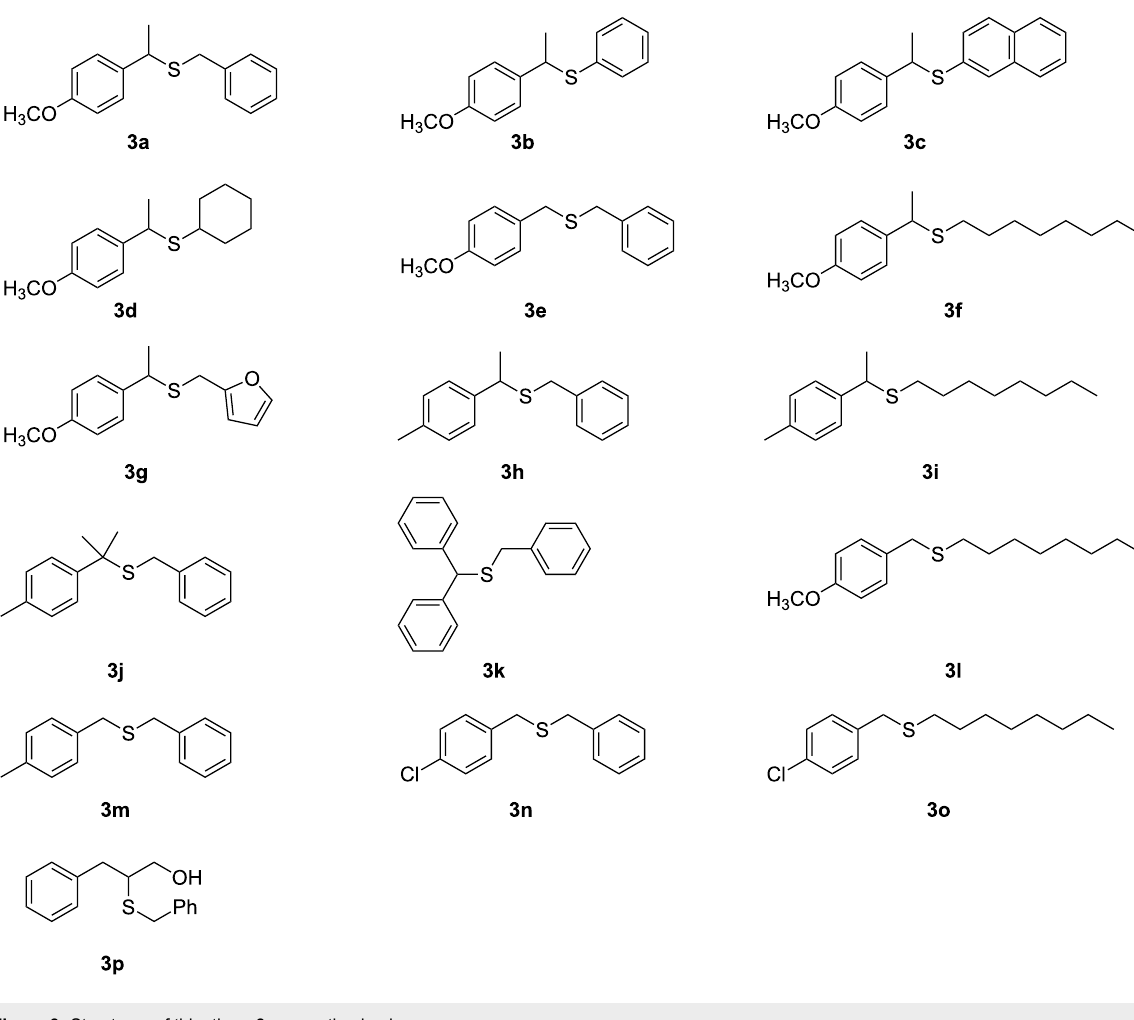
Figure 3: Structures of thioethers 3a–p